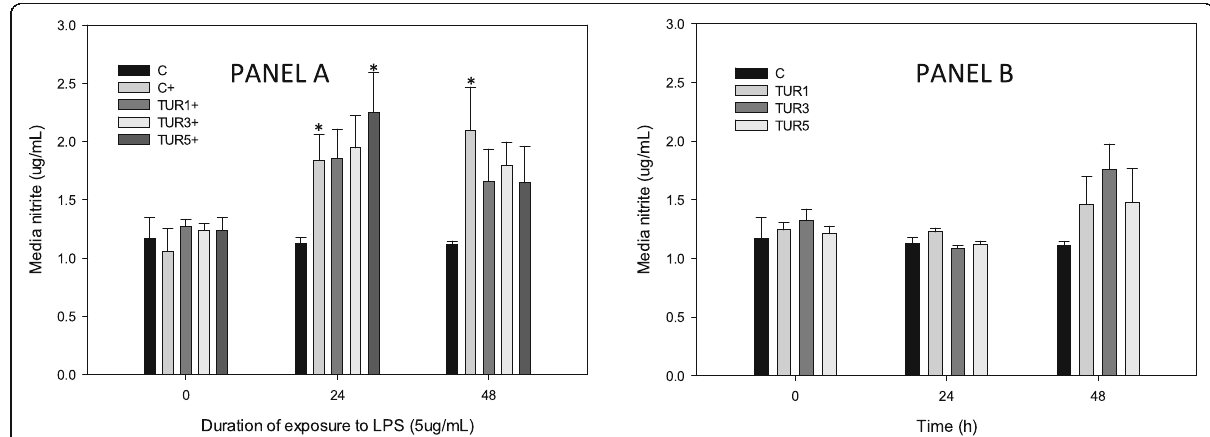
Fig. 3 NO production by cartilage explants conditioned with simulated biological extract of turmeric (3, 9 or 15 μ g/mL; TUR1, TUR3 and TUR5 respectively) compared with simulated biological extract containing no turmeric (C) in the presence (Panel a ) or absence (Panel b ) of lipopolysaccharide (LPS; 5 μ g/mL). Explants were cultured for a total of 96 h and were conditioned with TUR for the first 48 h prior to exposure to LPS. Data are shown for the final 48 h only. * denotes significant change from